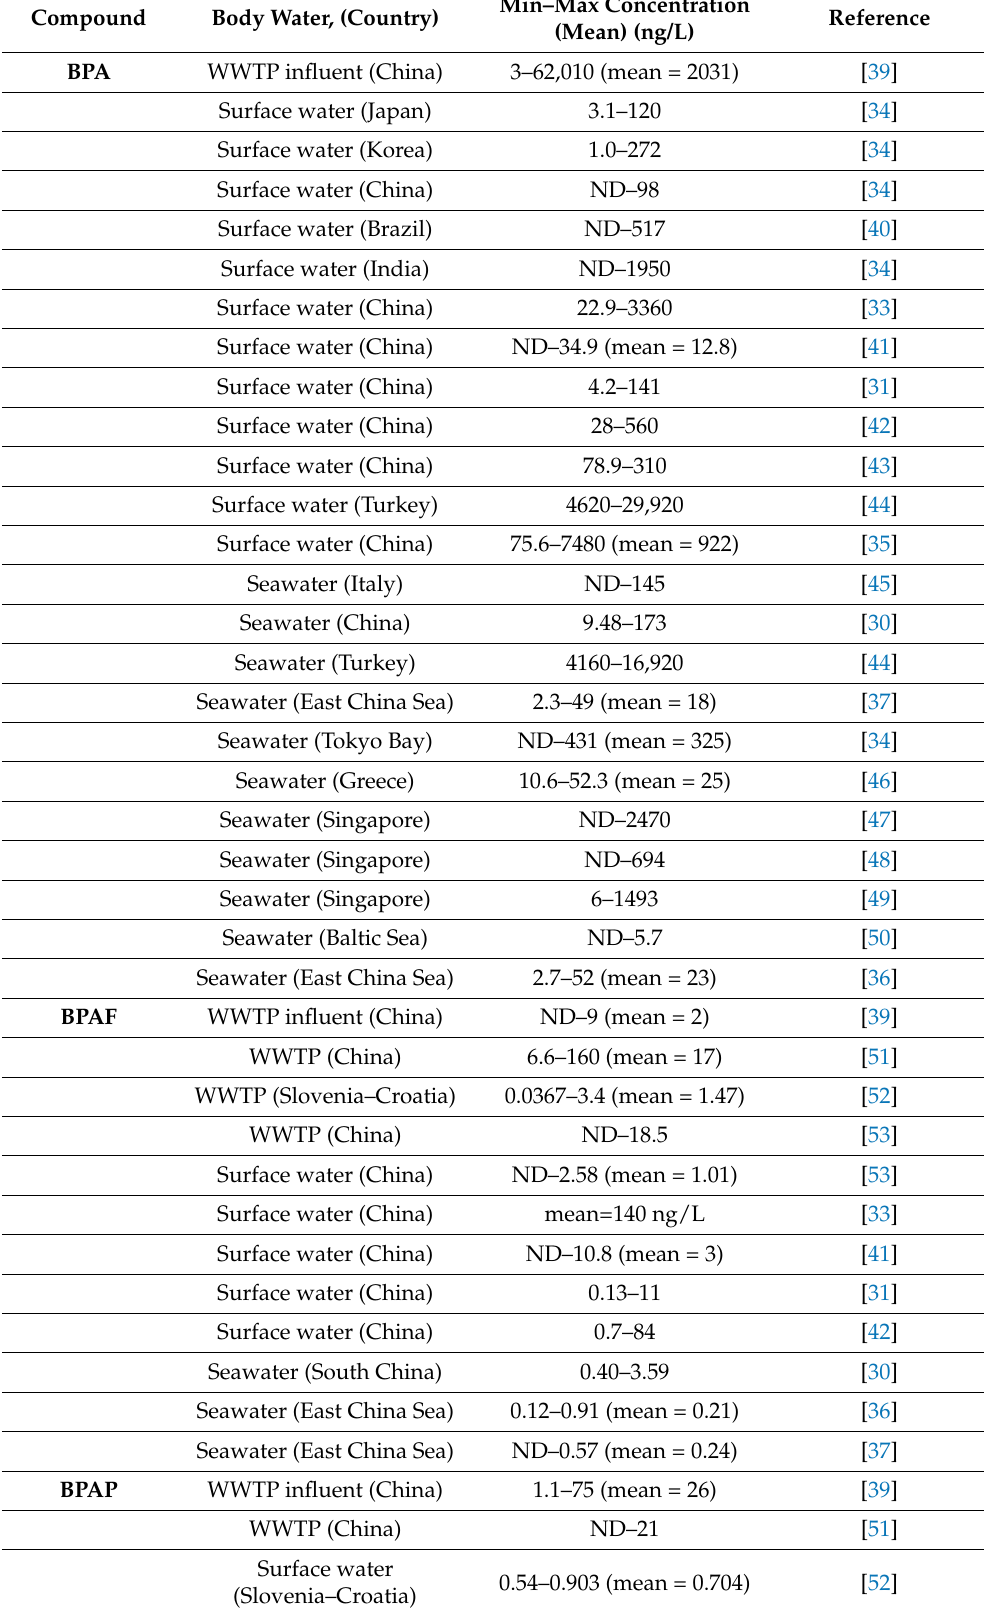
Table 2. Bisphenol analogs concentrations in WWTPs, surface waters, and seawaters around the